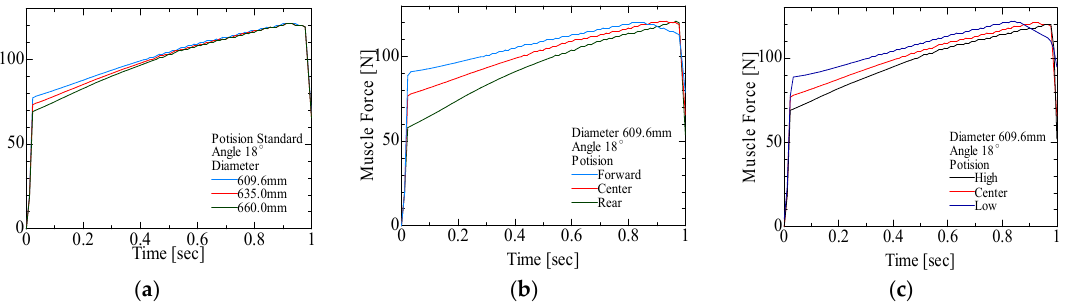
Figure 3. Comparison of muscle strength in the triceps brachialis muscle (model B). ( a ) Wheel